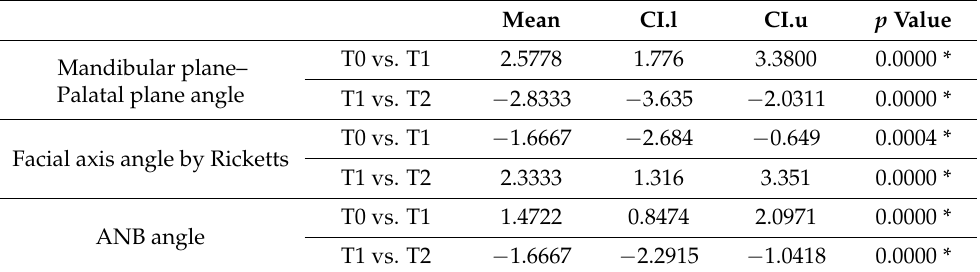
Table 4. Changes in Mandibular plane–Palatal plane angle, Facial axis angle by Ricketts and ANB angle (* p <